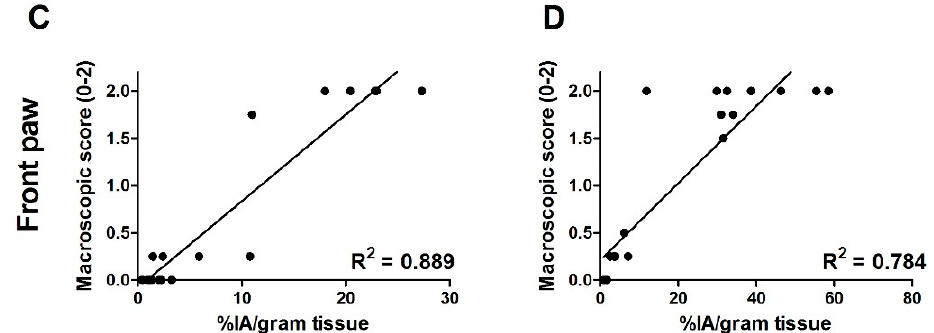
Figure 3. Uptake of 700DX-loaded and control liposomes positively correlated with macroscopic arthritis score in the hind ankle ( A , B ) and front paw ( C , D ) of mice with CIA ( n = 10 mice).